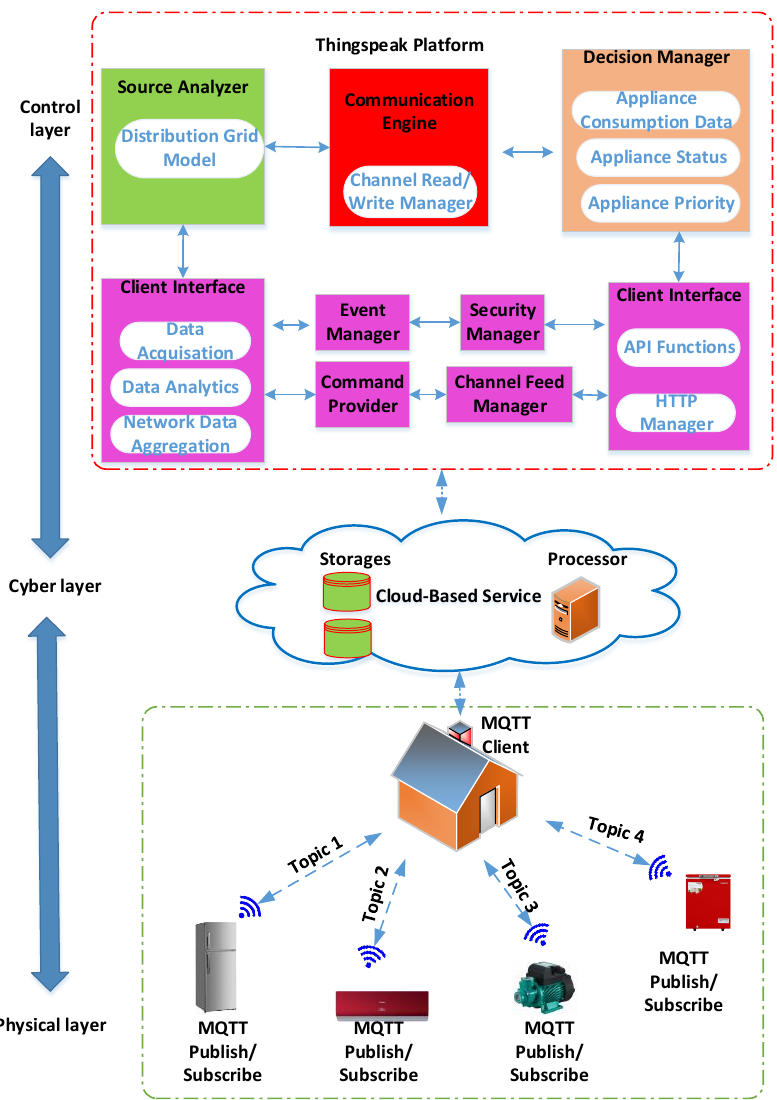
Figure 10. Proposed communication architecture of microgrid.